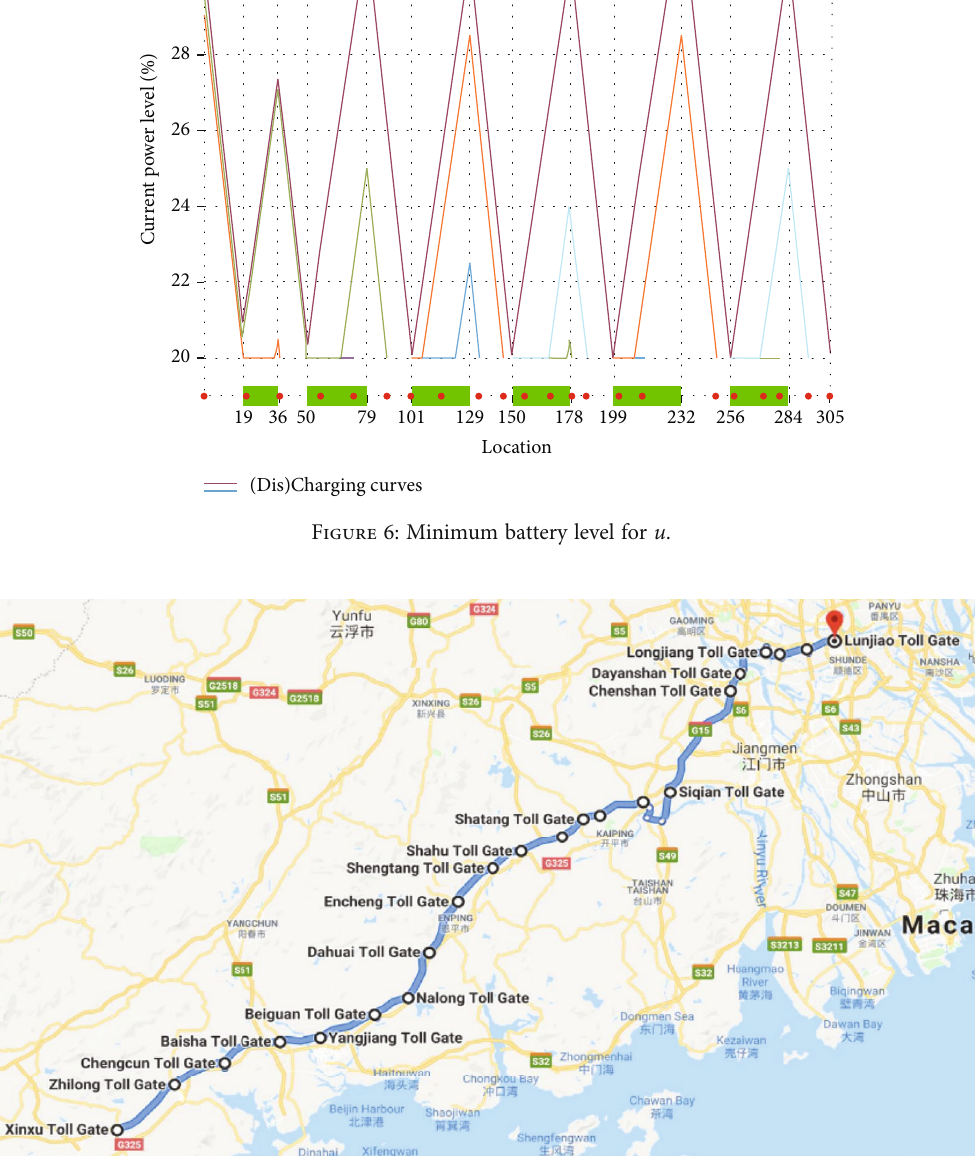
Figure 7: Toll station